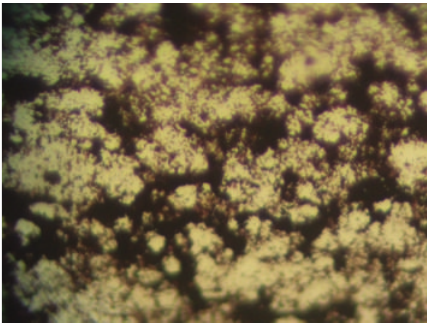
Figure 5: Photomicrograph of smear stained with Fontana Masson ×